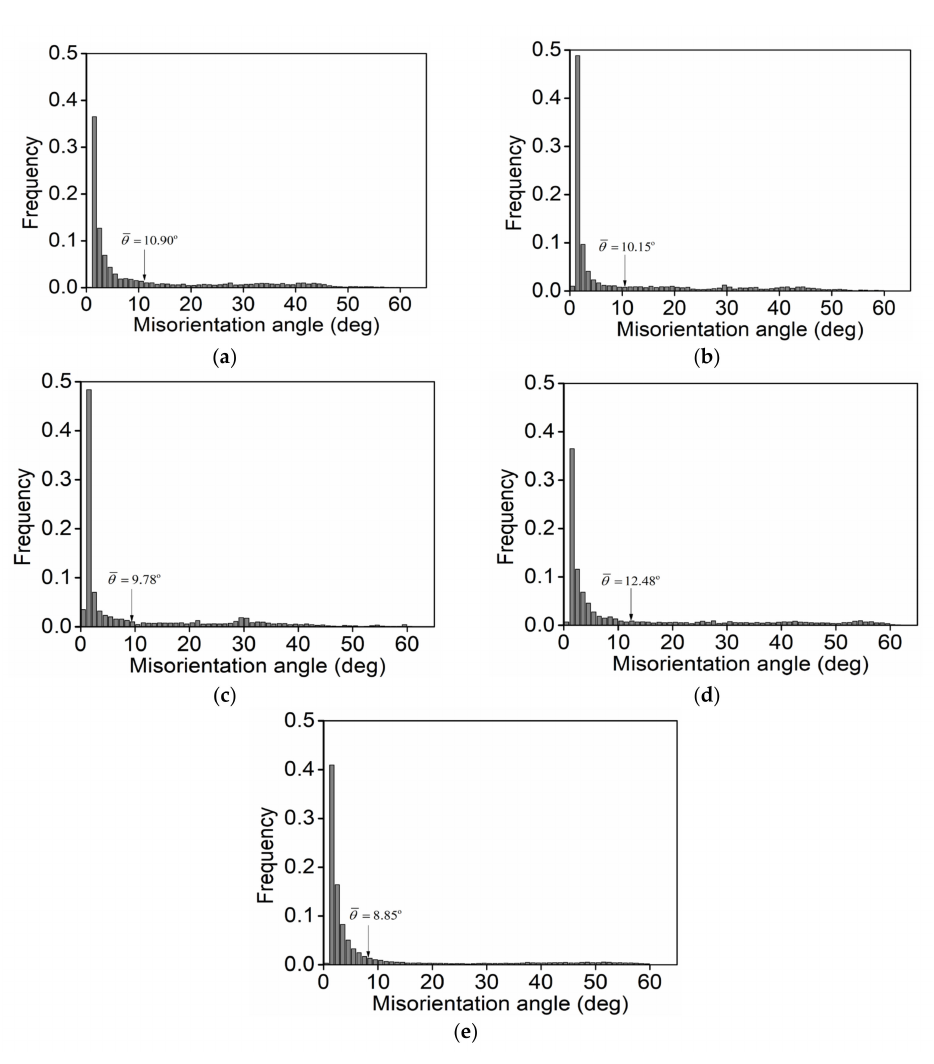
Figure 6. Misorientation angle scatters of the investigated titanium alloy at: ( a ) 890 ◦ C/ 0.1 s − 1 / ε I = 0.3/0.001 s − 1 , ( b ) 920 ◦ C/0.1 s − 1 / ε I = 0.3/0.001 s − 1 , ( c ) 950 ◦ C/0.1 s − 1 / ε I = 0.3/0.001 s − 1 , ( d ) 920 ◦ C/0.1 s − 1 / ε I = 0.9/0.001 s − 1 . ( e ) 920 ◦ C/0.1 s − 1 / ε I = 0.3/1 s − 1 .